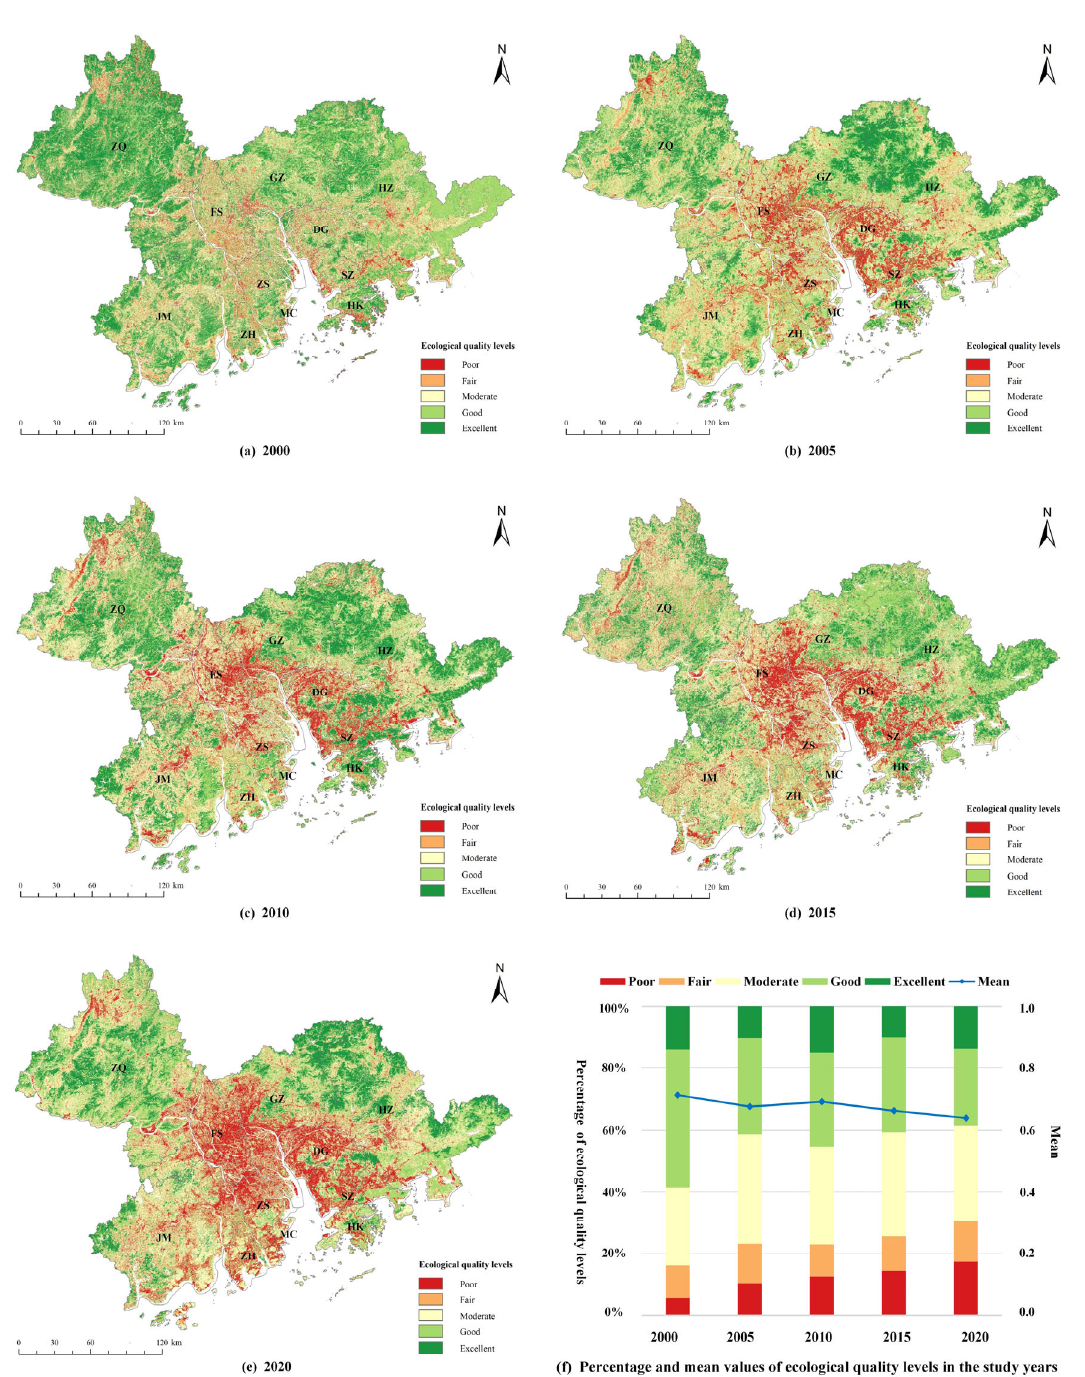
Figure 5. Ecological quality of the GBA from 2000 to 2020.